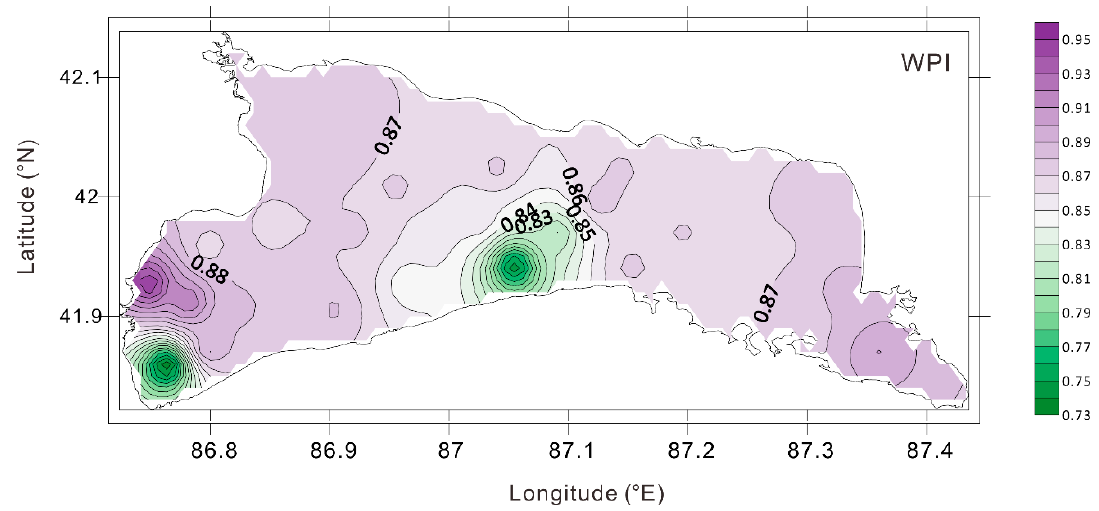
Figure 12. Spatial distribution maps of the water pollution index (WPI), in Bosten Lake.